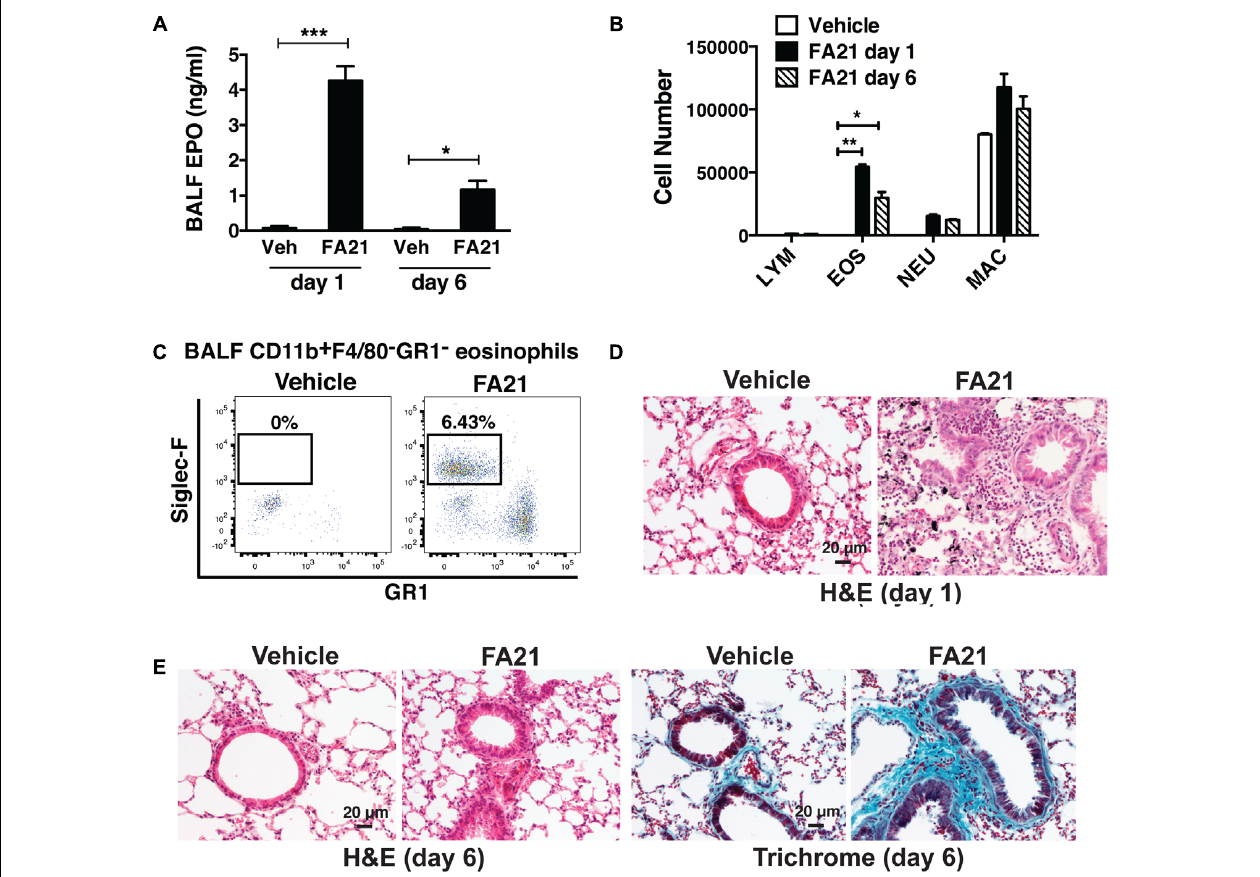
FIGURE 2 | Intratracheal administration of high nickel MWCNT elicited pulmonary eosinophilic inflammation. To examine the inflammatory properties of high nickel MWCNT, 50 µ g of FA21 was administered to C57BL/6 mice (4–6 mice per group) by oropharyngeal instillation (30 µ l). Controls comprised of mice treated with dispersion medium alone (vehicle). To examine the resultant inflammatory response, Bronchoalveolar lavage fluid (BALF) and lung tissue were collected for analysis 1 and 6 days after FA21 administration. (A) Eosinophil peroxidase (EPO) activity expressed by BALF cells collected 1 or 6 days after FA21 or vehicle exposure was determined by colorimetric assay. (B) BALF cell differential counts were determined and expressed as absolute cell numbers per mouse of lymphocytes (LYM), macrophages (MAC), eosinophils (EOS), and polymorphonuclear neutrophils (NEU). Results are mean ± SEM ( n = 6), ∗ p < 0.05, ∗∗ p < 0.01, and ∗∗∗ p < 0.001. (C) CD11b + F4/80 - GR1 - Siglec-F + eosinophil numbers present in the BALF collected 24 h after vehicle or FA21 exposure was determined by flow cytometry. (D) Pulmonary inflammation was determined by histological analysis of H&E-stained lung tissue collected 24 h after vehicle or FA21 exposure (20 × ). Lung tissue images from FA21-exposed mice show evidence of MWCNT agglomerates (appear as black aggregates). (E) Pulmonary inflammation and collagen deposition in lung tissue collected 6 days after vehicle or FA21 exposure was assessed by histological analysis of H&E- and Trichrome-stained segments, respectively (20 × ). Data are representative of 4 independent